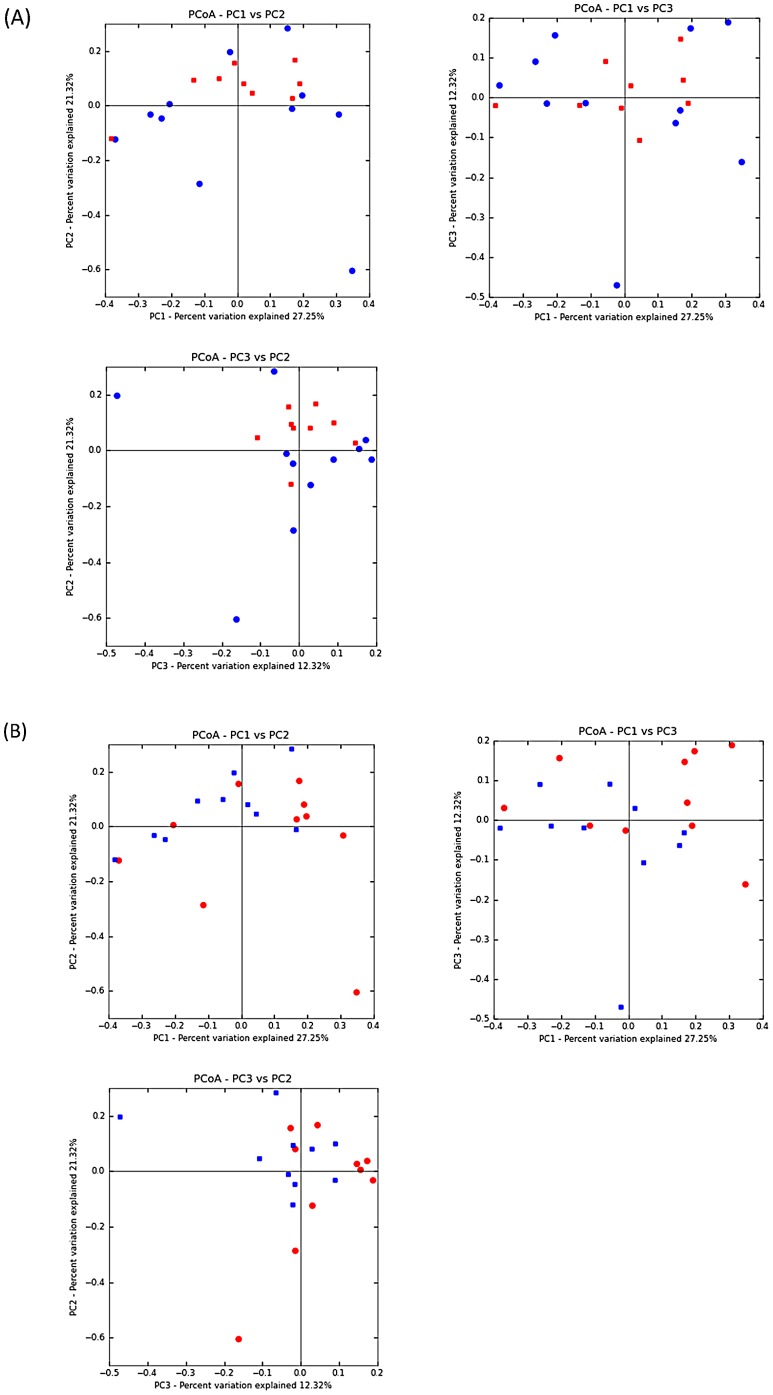
Principal component analysis of Uni Frac distance metric.Plot (A) was generated using sequences from individual pigs at week 2 post-weaning fed High (blue circles) or Low (red squares) complexity diets from 0–6 weeks post-weaning. Plot (B) was generated using sequences from individual pigs at week 2 fed diets with (blue squares) or without (red circles) antibiotics. All pigs received a common grower diet thereafter.